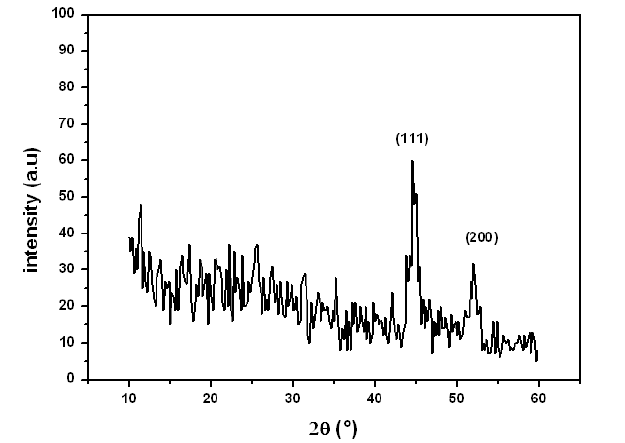
Figure 1. XRD patterns of the prepared nickel